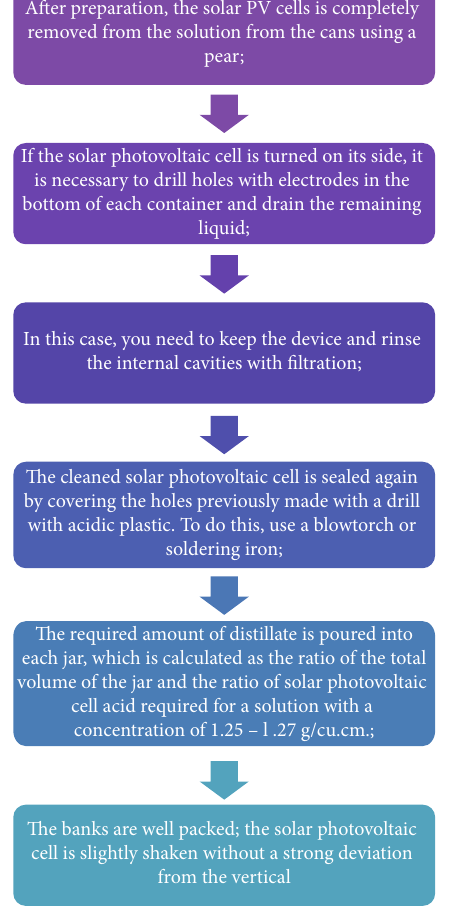
Figure 4: Reduced resource